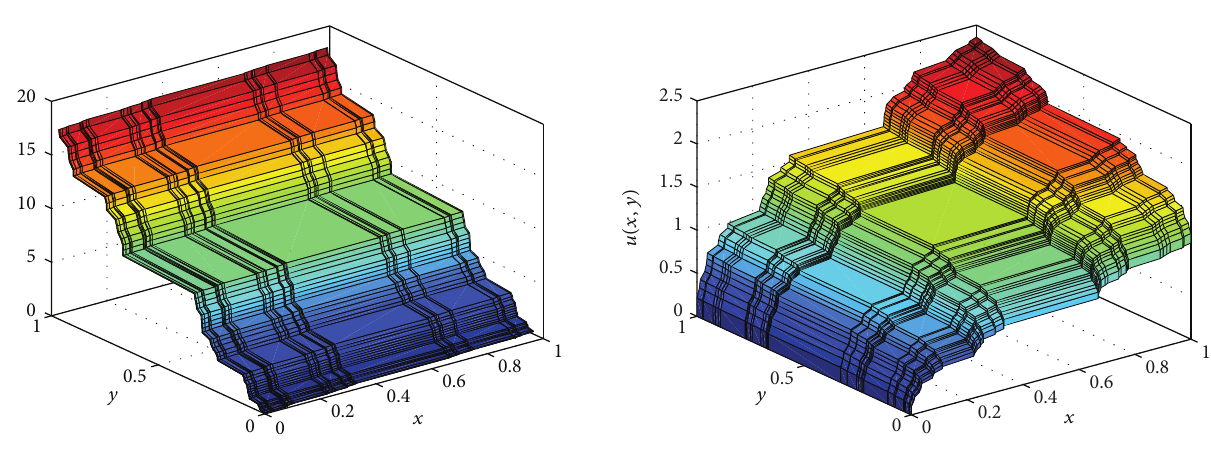
Figure 6: The plot of 𝑢(𝑥,𝑦) with the parameter 𝛼 = ln 2/ ln 3